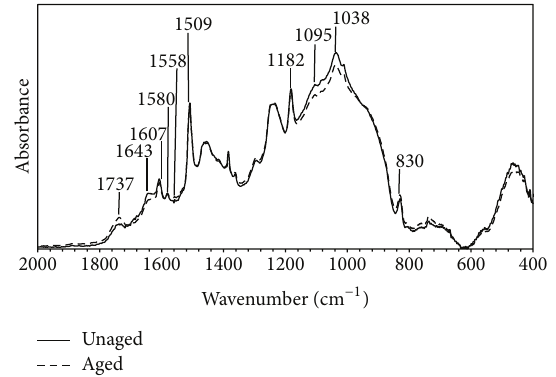
Figure 11: FTIR spectra of EHG250-68-37 composite sample in the carbonyl region (initially and after 800 h thermooxidative aging).